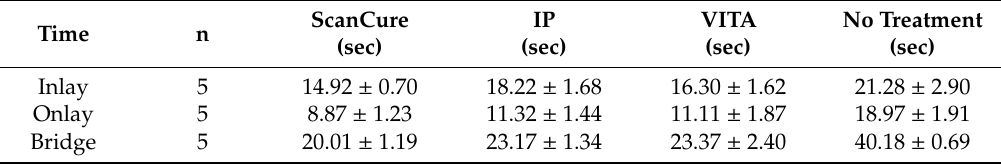
Table 4. Working times, according to scanning-aid materials (mean ± SD) Time